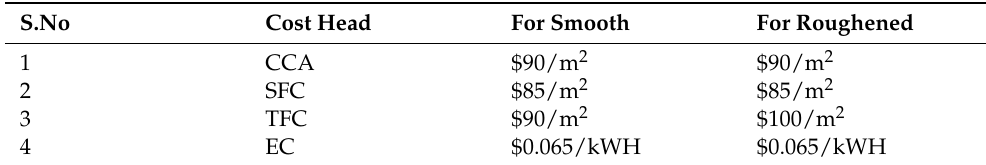
Figure 20. (cid:3)>(cid:2)(cid:8) variations for jet and smooth surface collector. Figure 20. CBTR variations for jet and smooth surface collector. Table 1. Associated